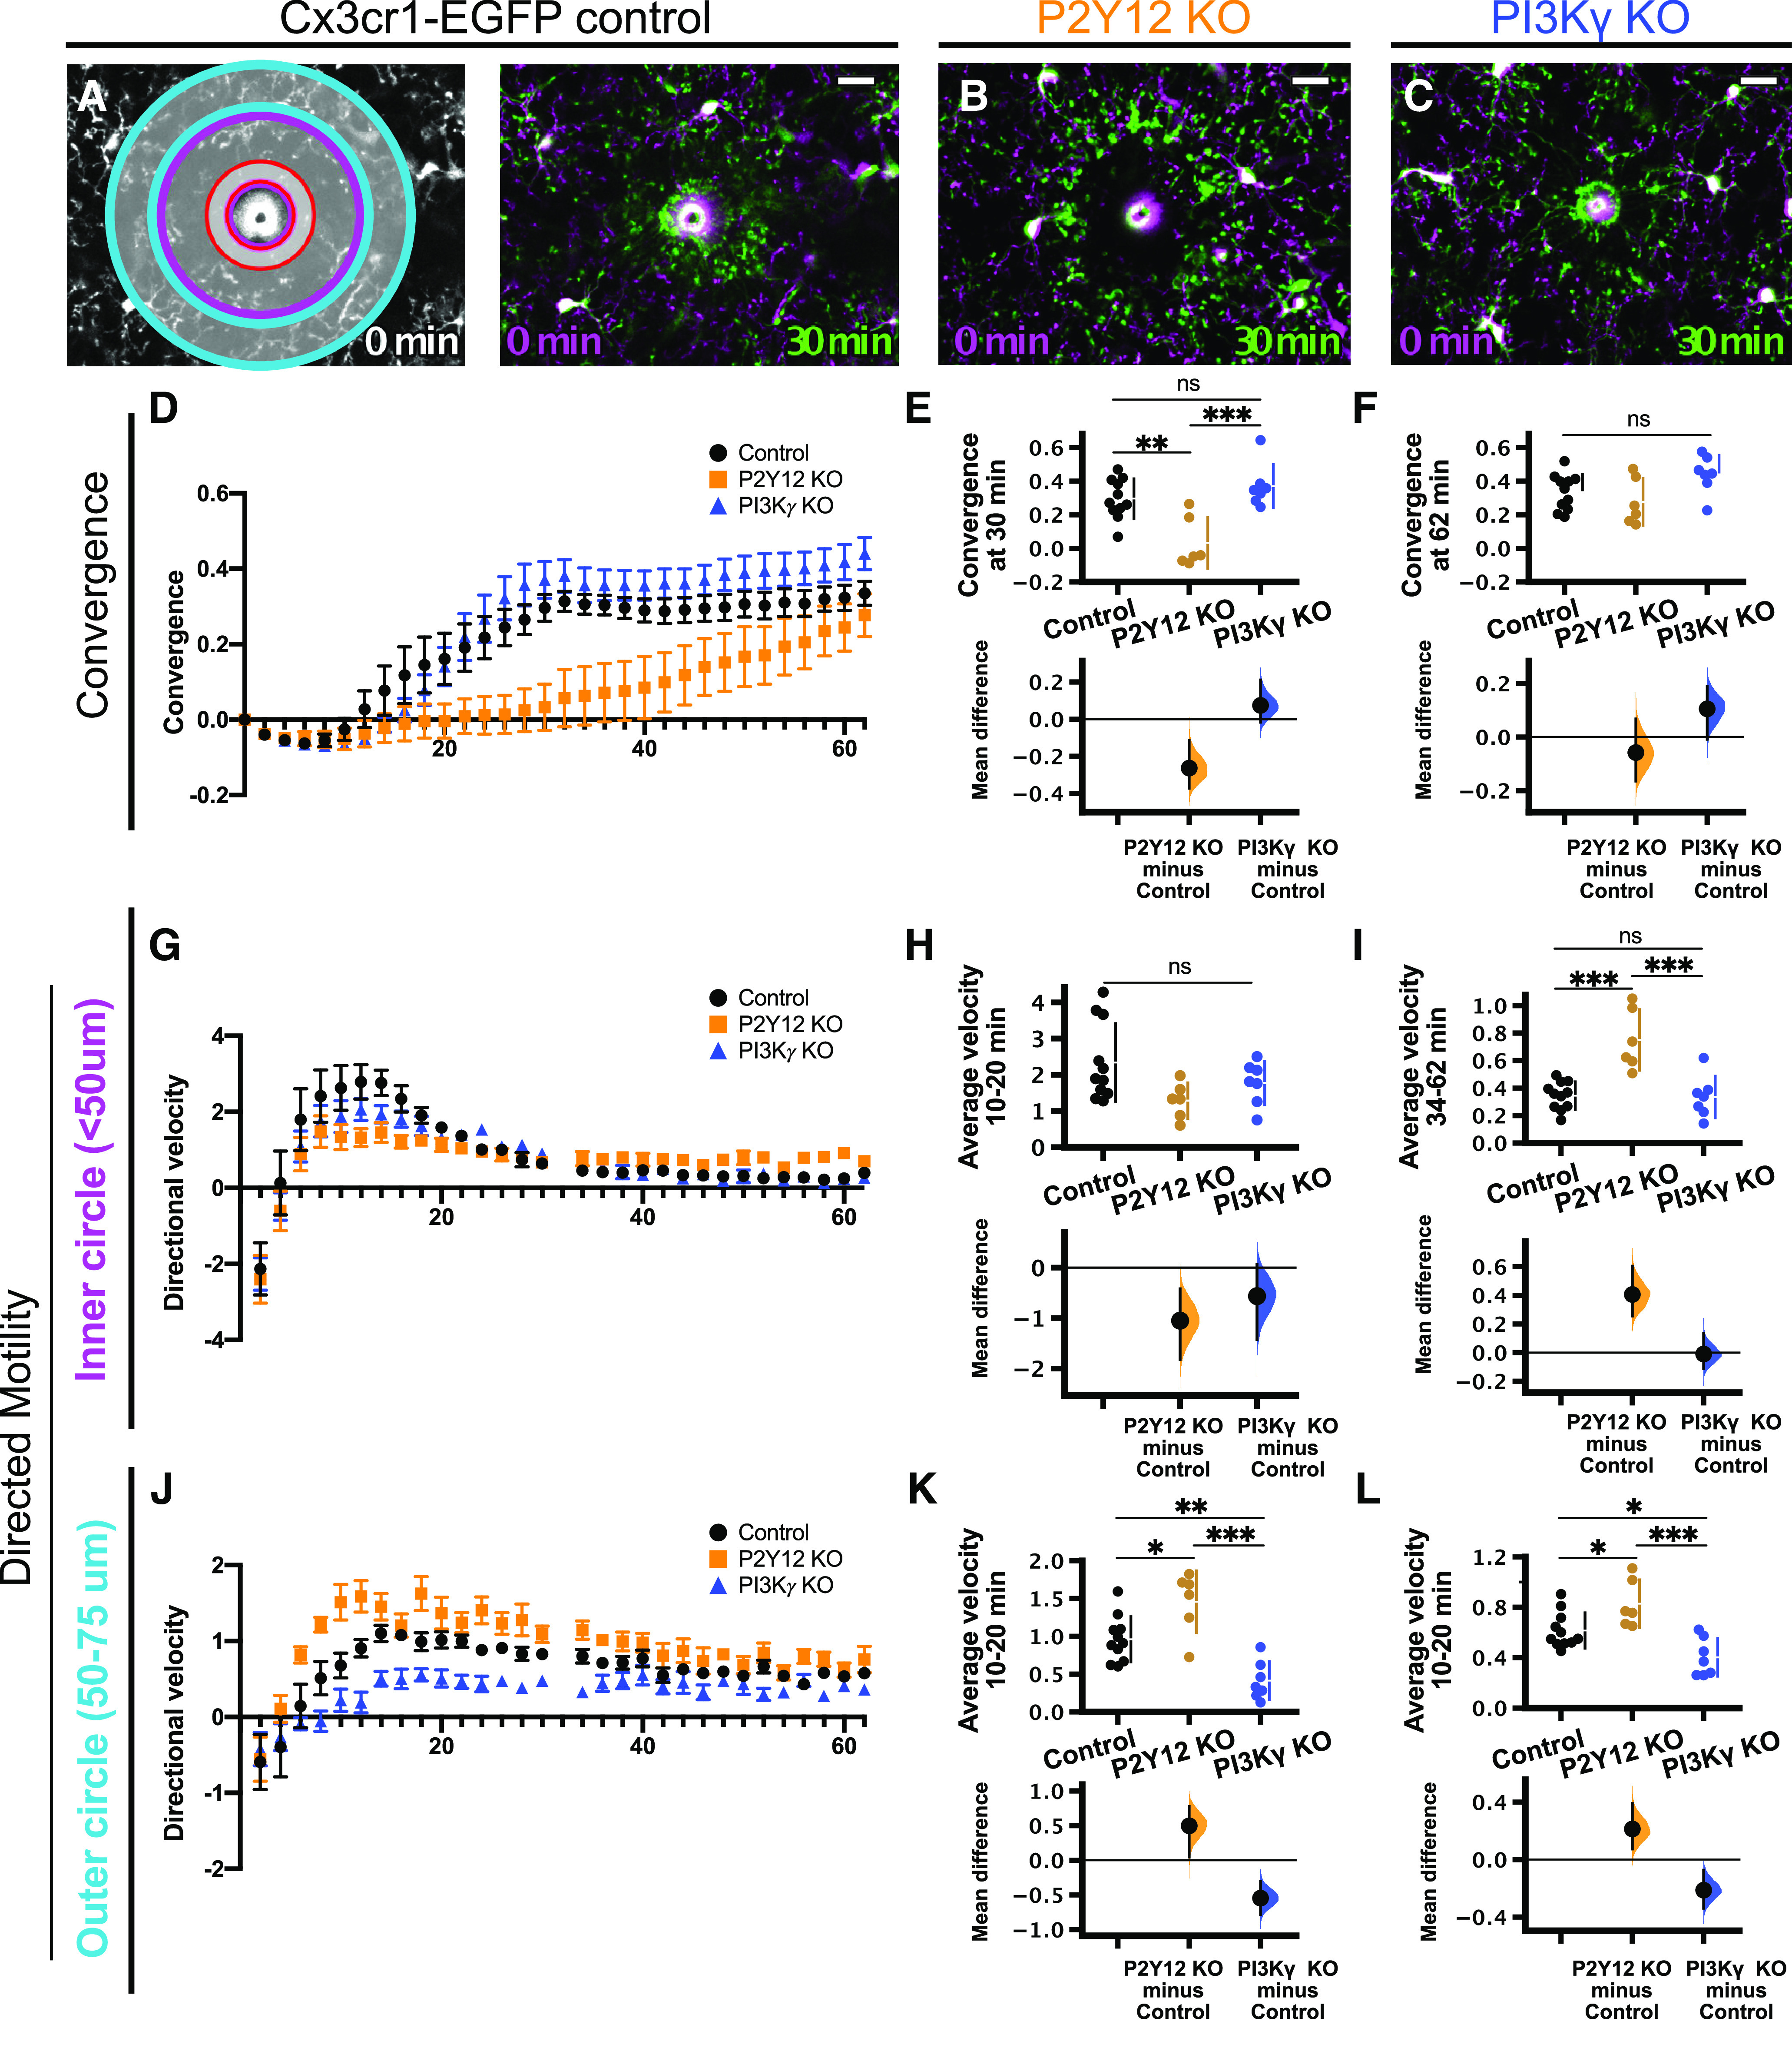
PI3Kγ is not required for the microglial response to laser injury in vivo. Representative images of the microglial response to laser injury in vivo in control (A, n = 11 mice), P2Y12 KO (B, n = 6 mice), and PI3Kγ KO (C, n = 7 mice) at the time points indicated. Images at 30 min after injury (green) are overlaid with initial images (t = 0 min, magenta). The first panel shows the approximate regions of interest used for each type of analysis: convergence (red), inner circle motility (purple), and outer circle motility (cyan). D, Time course of convergence over a 62-min imaging session. E, Convergence at 30 min is similar in control and PI3Kγ KO groups, while P2Y12 KO microglia do not converge at this time point [one-way ANOVA p = 0.0003; Tukey’s test: control vs P2Y12 KO p = 0.0018; control vs PI3Kγ KO p = 0.48; P2Y12 KO vs PI3Kγ KO p = 0.0004; mean differences vs control: P2Y12 KO −0.263 (95%CI −0.372, −0.112); PI3Kγ KO 0.0741 (95%CI −0.0165, 0.211)]. F, By 62 min, convergence across all groups is similar [one-way ANOVA, p = 0.055; mean differences vs control: P2Y12 KO −0.058 (95%CI −0.165, 0.068); PI3Kγ KO 0.105 (95%CI −0.00849, 0.19)]. G, Time course of directional velocity within the inner circle (<50 μm from center of injury). Note there is a missing time point at t = 32 min because of a discontinuity in image acquisition that affects the optic flow calculations. H, There were no differences between genotypes in the directional velocity during the peak of the response [average velocity calculated in the interval of 10–20 min after injury; one-way ANOVA p = 0.063; mean differences vs control: P2Y12 KO −0.058 (95%CI −0.165, 0.068); PI3Kγ KO 0.105 (95%CI −0.00849, 0.19)]. I, However, P2Y12 KO microglia had sustained movement toward the injury site, which was significantly higher than control or PI3Kγ KO groups [average velocity calculated in the interval of 34–62 min; one-way ANOVA p < 0.0001; Tukey’s test: control vs P2Y12 KO p < 0.0001; control vs PI3Kγ KO p = 0.99; P2Y12 KO vs PI3Kγ KO p = 0.0002; mean differences vs control: P2Y12 KO 0.406 (95%CI 0.255, 0.603); PI3Kγ KO −0.00985 (95%CI −0.112, 0.134)]. J, Time course of directional velocity within the outer circle (50–75 μm from injury center). K, P2Y12 KO mice showed increased directional velocity during the peak of the response (10–20 min) compared with control, while PI3Kγ KO show decreased directional velocity during this time [one-way ANOVA p < 0.0001; Tukey’s test: control vs P2Y12 KO p = 0.0152; control vs PI3Kγ KO p = 0.0051; P2Y12 KO vs PI3Kγ KO p < 0.0001; mean differences vs control: P2Y12 KO 0.497 (95%CI 0.0439, 0.776); PI3Kγ KO −0.548 (95%CI −0.787, −0.305)]. L, These differences in directional response were sustained later in the injury response [34–62 min; one-way ANOVA p = 0.0003; Tukey’s test: control vs P2Y12 KO p = 0.036; control vs PI3Kγ KO p = 0.027; P2Y12 KO vs PI3Kγ KO p = 0.0002; mean differences vs control: P2Y12 KO 0.213 (95%CI 0.0734, 0.391); PI3Kγ KO −0.213 (95%CI −0.339, −0.0739)]. Comparisons (E, F, H, I, K, L) done using one-way ANOVA with Tukey’s post hoc comparisons; ns, non-significant; *p < 0.05, **p < 0.01, ***p < 0.001. Data presented as mean ± SEM. Scale bar: 20 μm. Heat maps of directional velocity as a function of both time and distance from injury are presented in Extended Data Figure 6-1.